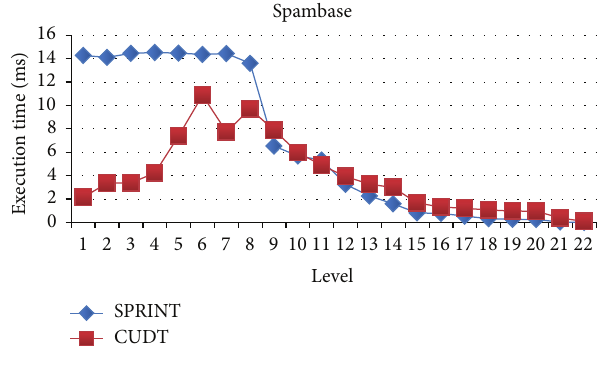
Figure 15: Execution time of each level on spambase.